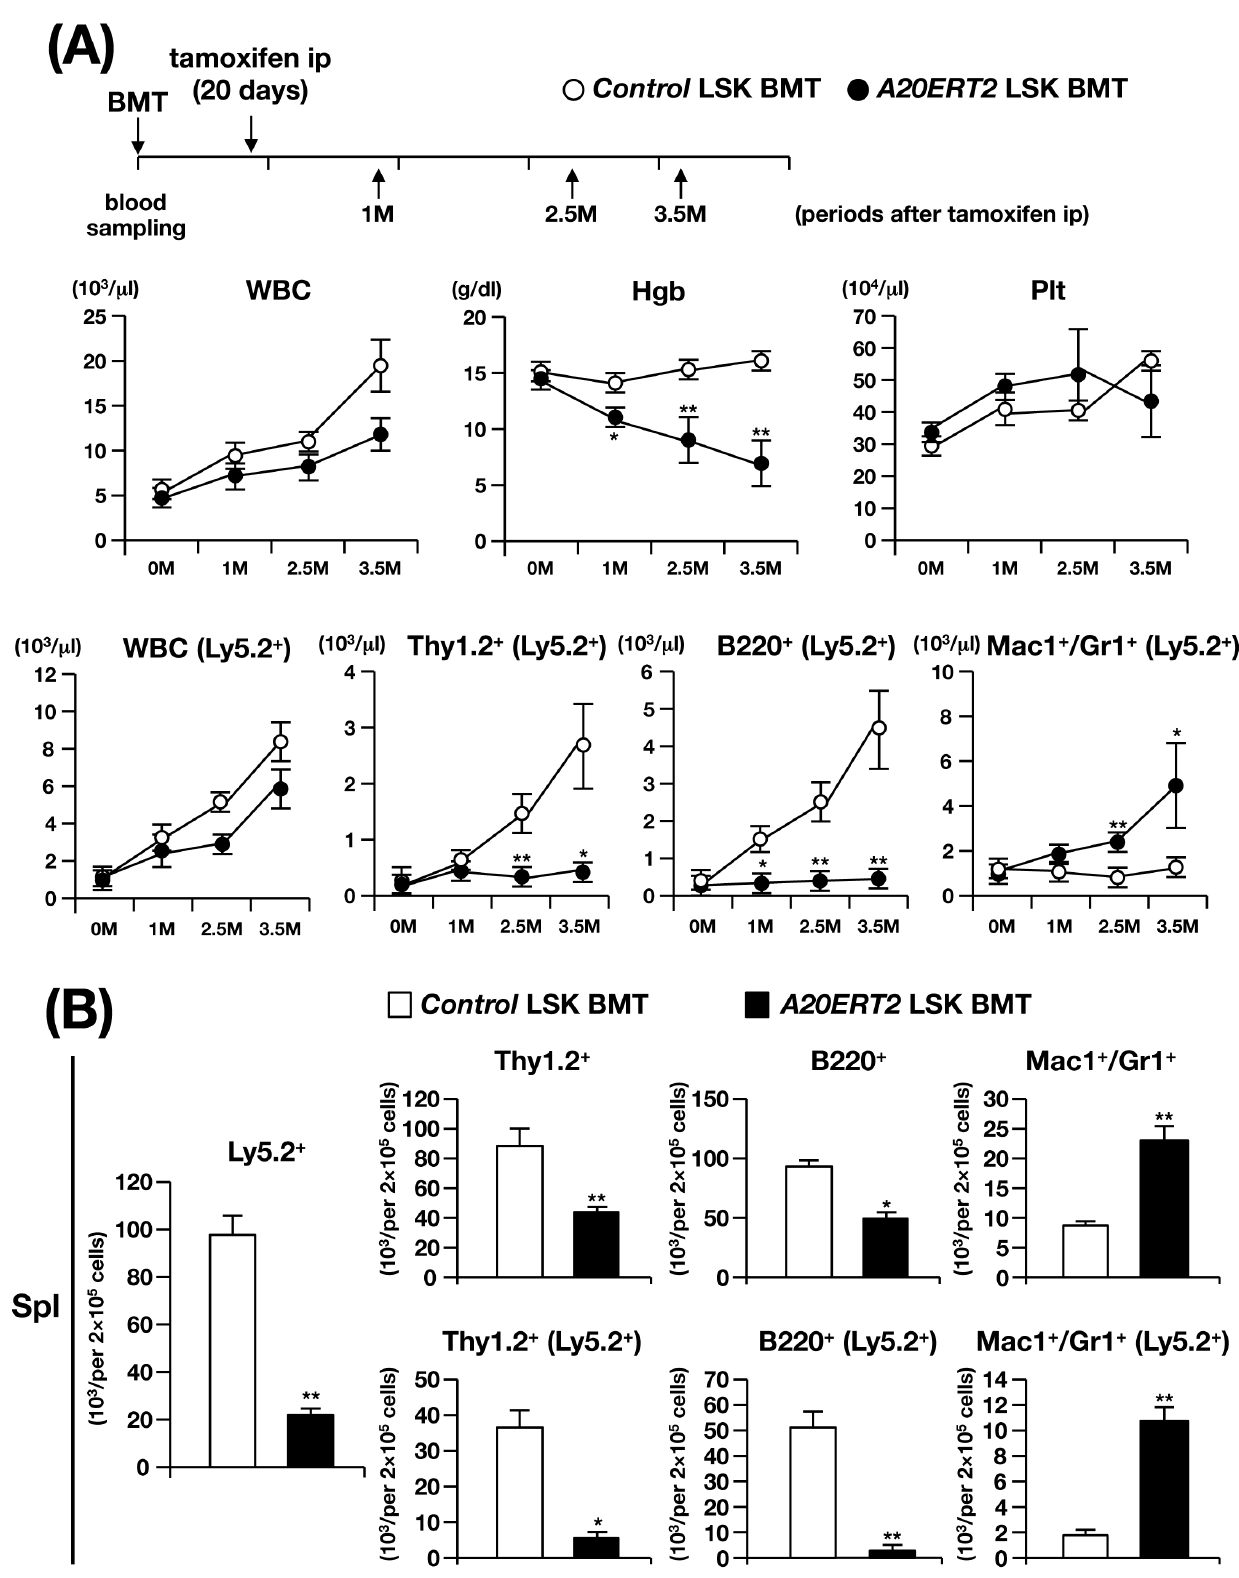
Figure 5. Analysis of control and A20ERT2 LSK BMT mice. (A) Time schedule of BMT, tamoxifen ip, blood sampling, and time-dependent changes of hematopoietic parameters and percentages of Ly5.2 + cells in the PB. *p , 0.05 and **p , 0.01 (Student’s t -test). (B) Percentages of different hematopoietic compartments and the population of Ly5.2 + cells in the spleen 3.5 M after transplantation. **p , 0.01 (Student’s t -test).